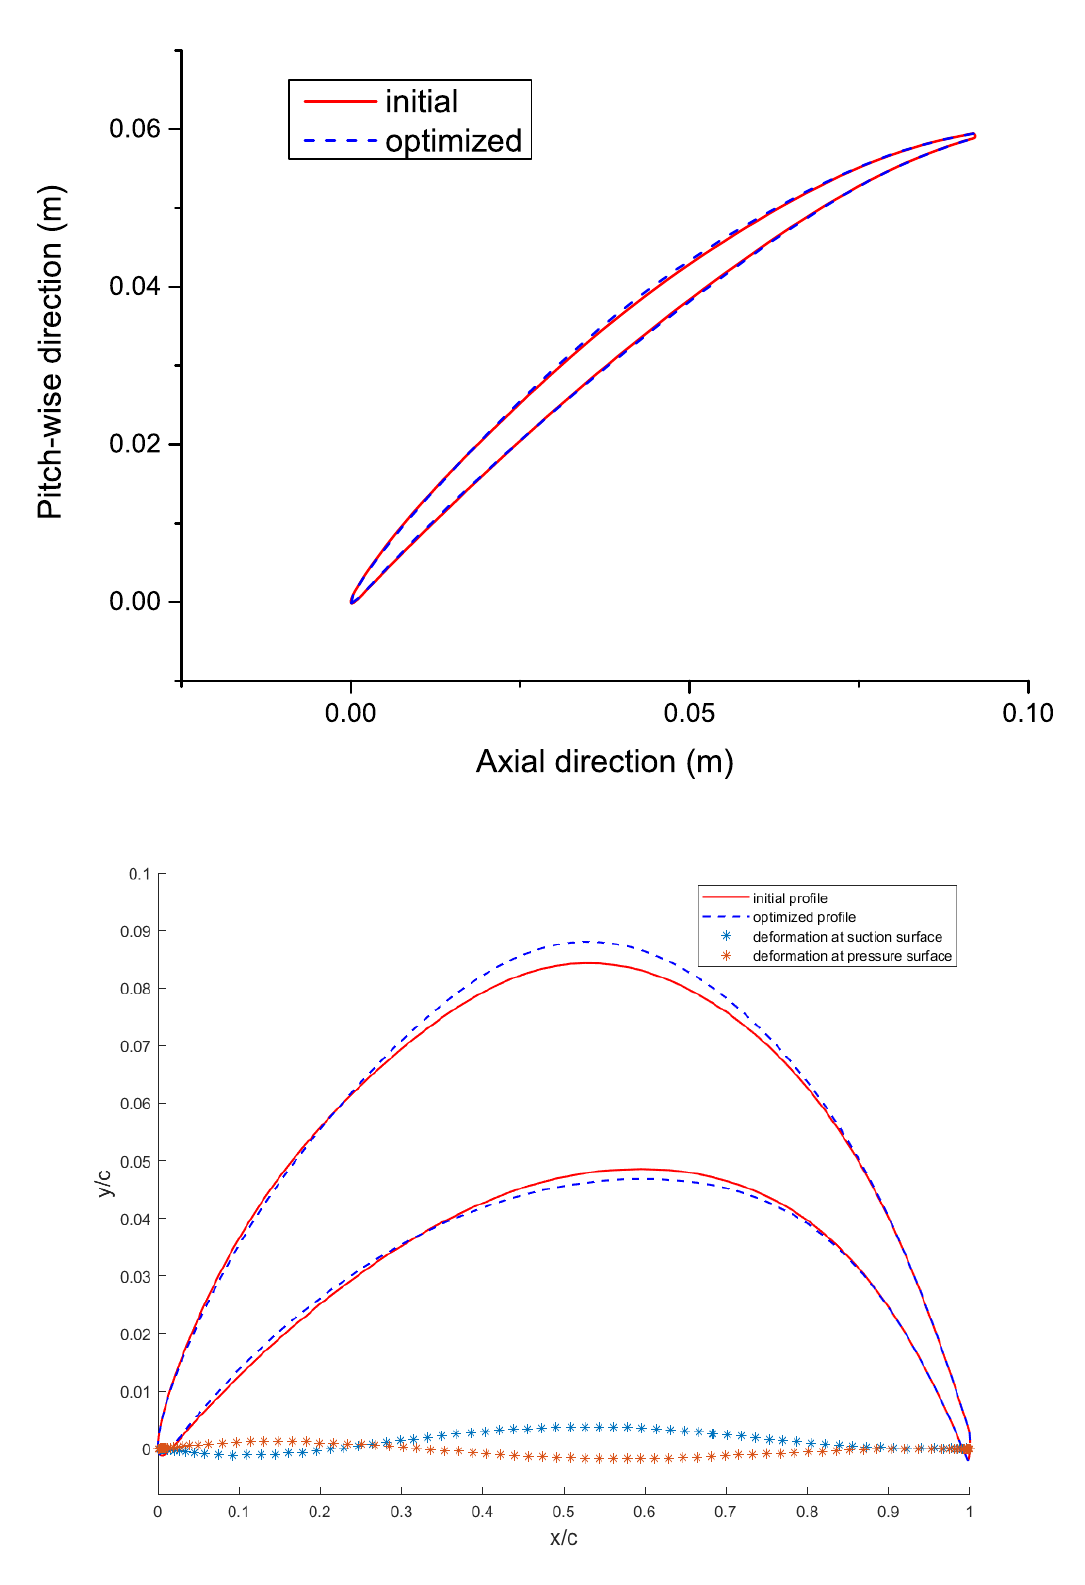
Figure 16. Initial and optimized blade profiles: comparison in terms of shape. The aerodynamic performance curves of the cascades of the original blade profile and the optimized profile are shown in Figure 17, respectively. In the operating region, with β 1 being 45.16 ◦ to 48.66 ◦ , ω of the cascade with the optimized blade profile